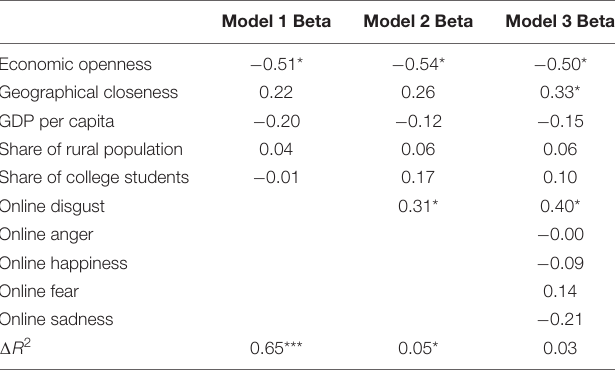
TABLE 2 | Nationalism and online disgust across 31 provinces in China, OLS